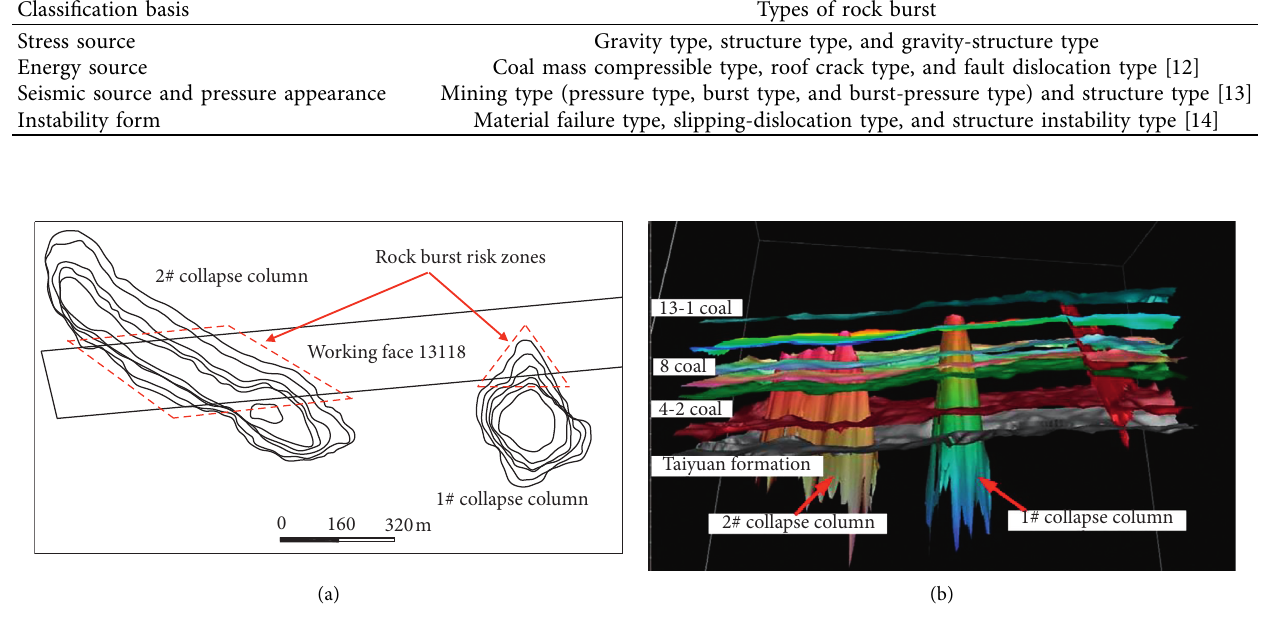
Figure 4: Distributions of collapse columns at the Xieqiao coal mine [20]. (a) Plane distribution. (b) Stereographic map.